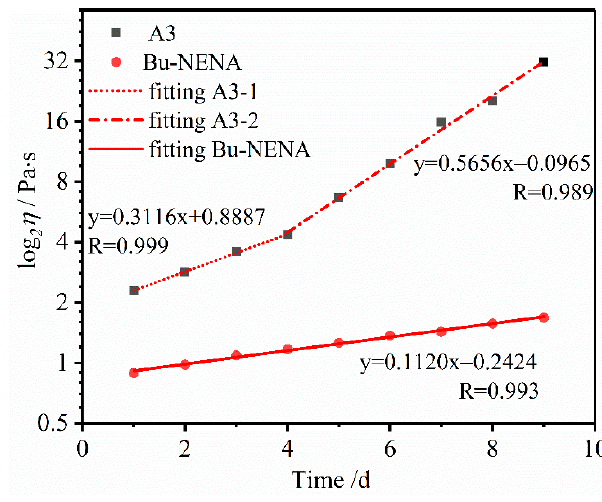
Figure 5. Viscosity data and fitting lines for PTPET with Bu-NENA and A3 at various time.